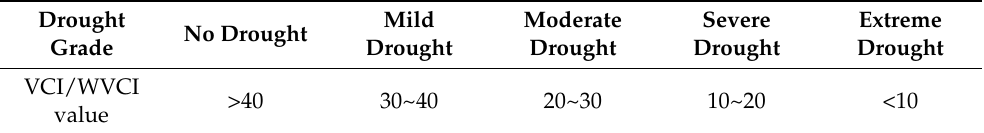
Table 1. Drought classification according to VCI/WVCI